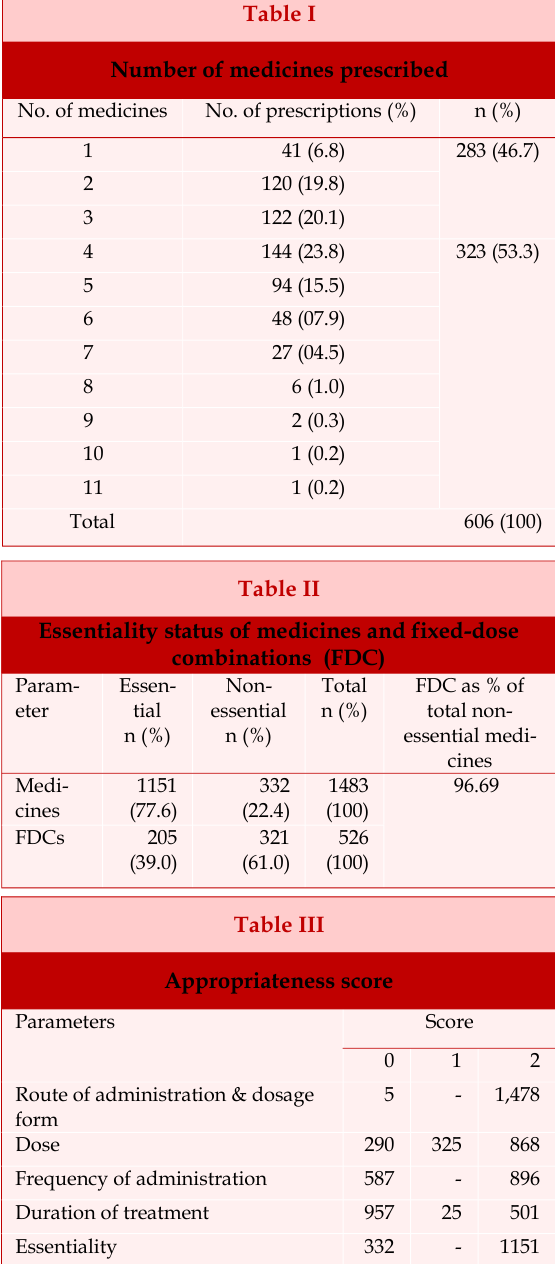
Essentiality status of medicines and fixed-dose